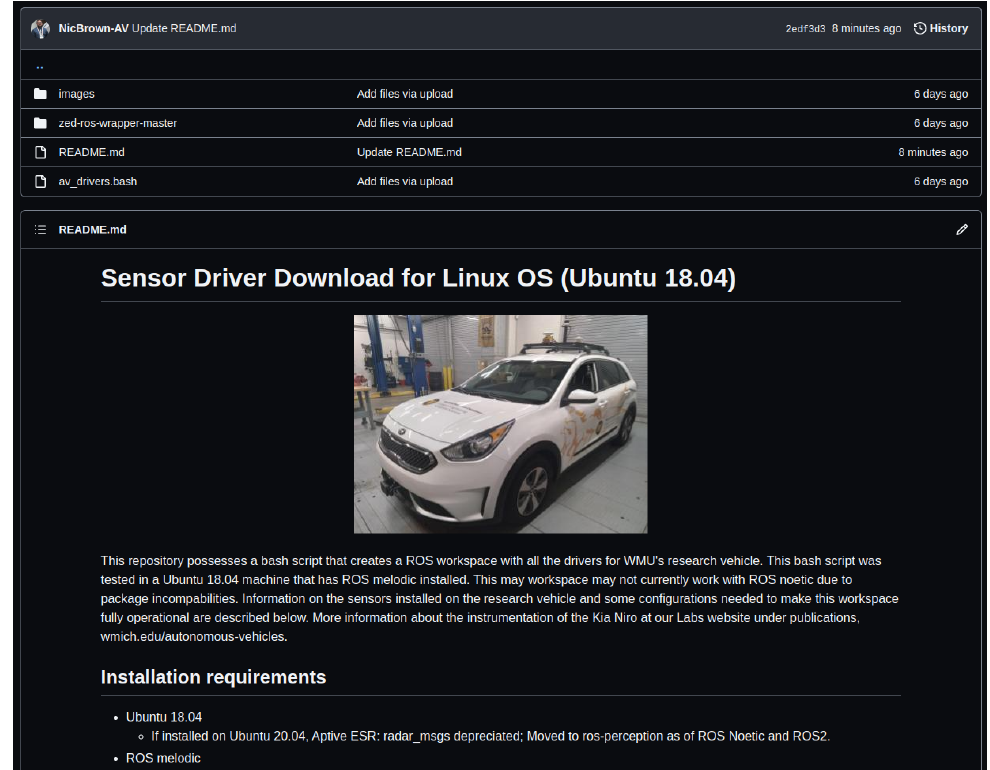
Figure A1. GitHub of the AV sensor drivers for ROS.